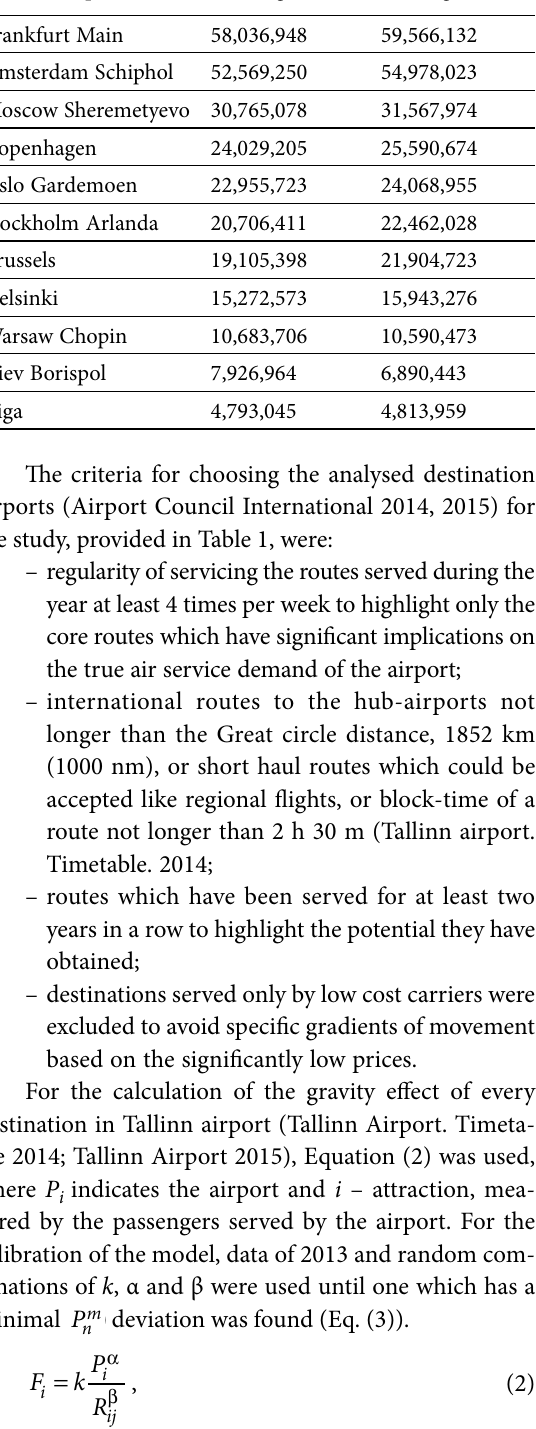
Table 1. Traffic data according to destinations for 2013 and 2014.